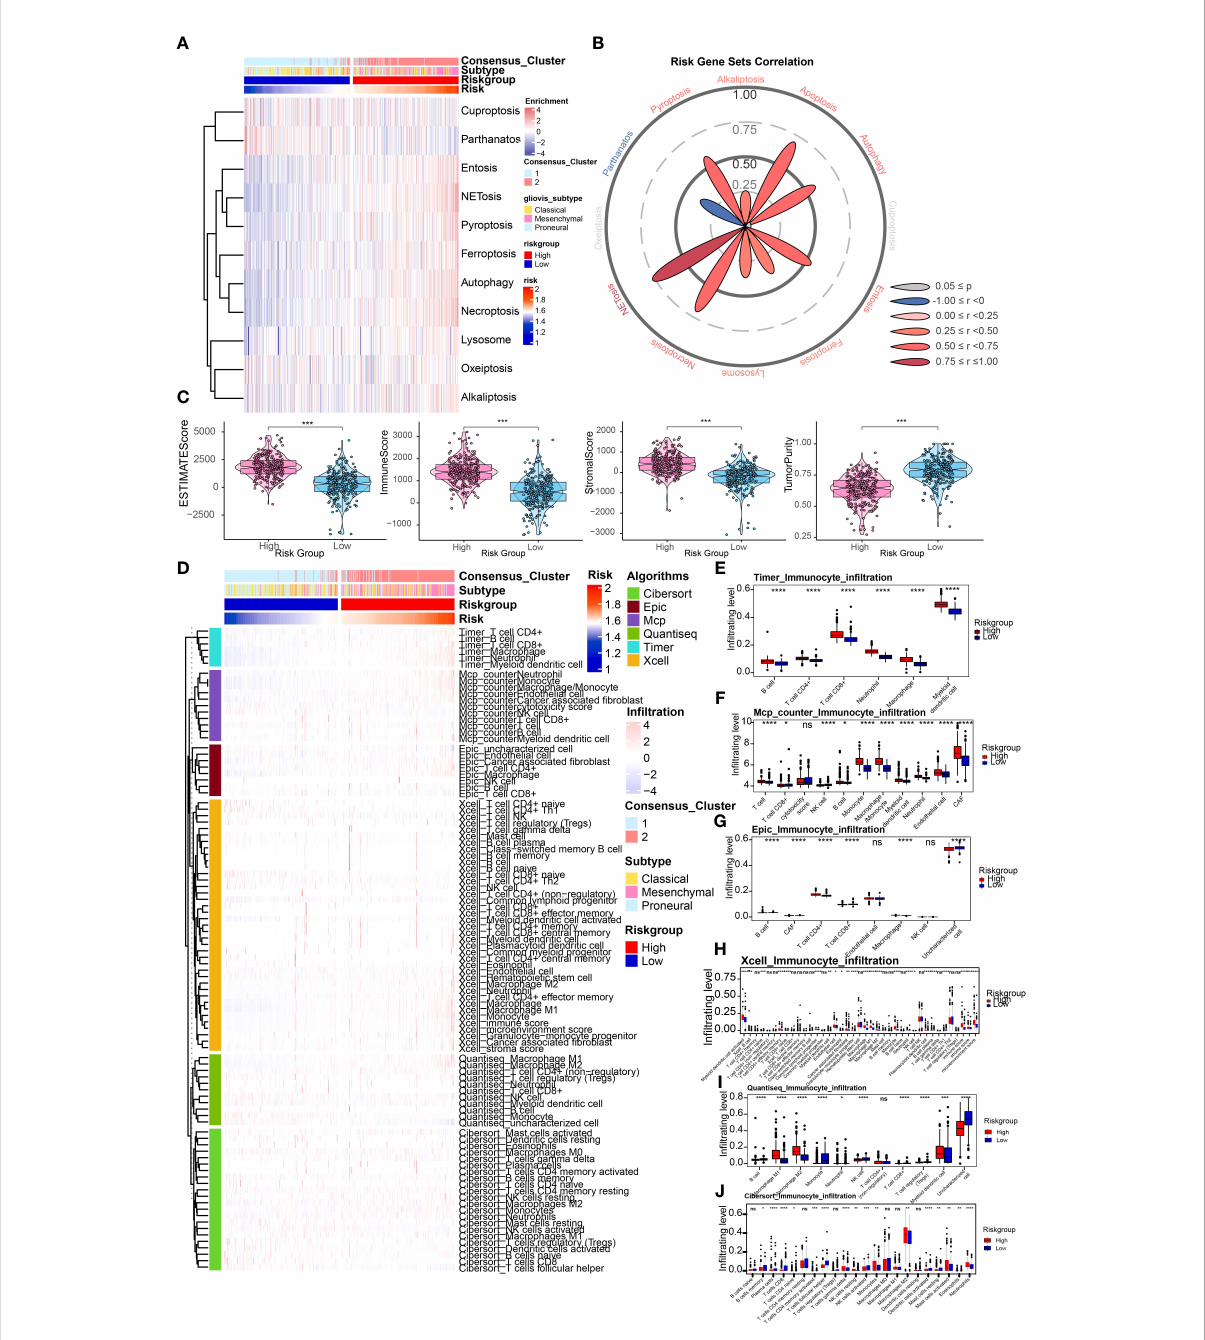
FIGURE 5 Depiction of tumor immune microenvironment on account of risk signature. (A) ssGSEA results of different cell death modes in TCGA Array dataset. (B) Correlation analysis of risk score and different cell death modes. (C) ESTIMATE score to predict tumor purity and the presence of in fi ltrating stromal cells/immune cells in tumor tissues based on the TCGA Array dataset. (D) Heatmap illustrated immune in fi ltration by performing the R package which integrates TIMER, MCP-counter, EPIC, xCell, quanTIseq, and CIBERSORT in the TCGA Array dataset. (E-J) Box plots displayed immune in fi ltration differences between high and low risk group by applying TIMER (E) , MCP-counter (F) , EPIC (G) , xCell (H) , quanTIseq (I) , and CIBERSORT (J) . NS, non-signi fi cant. *P < 0.05, **P < 0.01, ***P < 0.001, ****P <